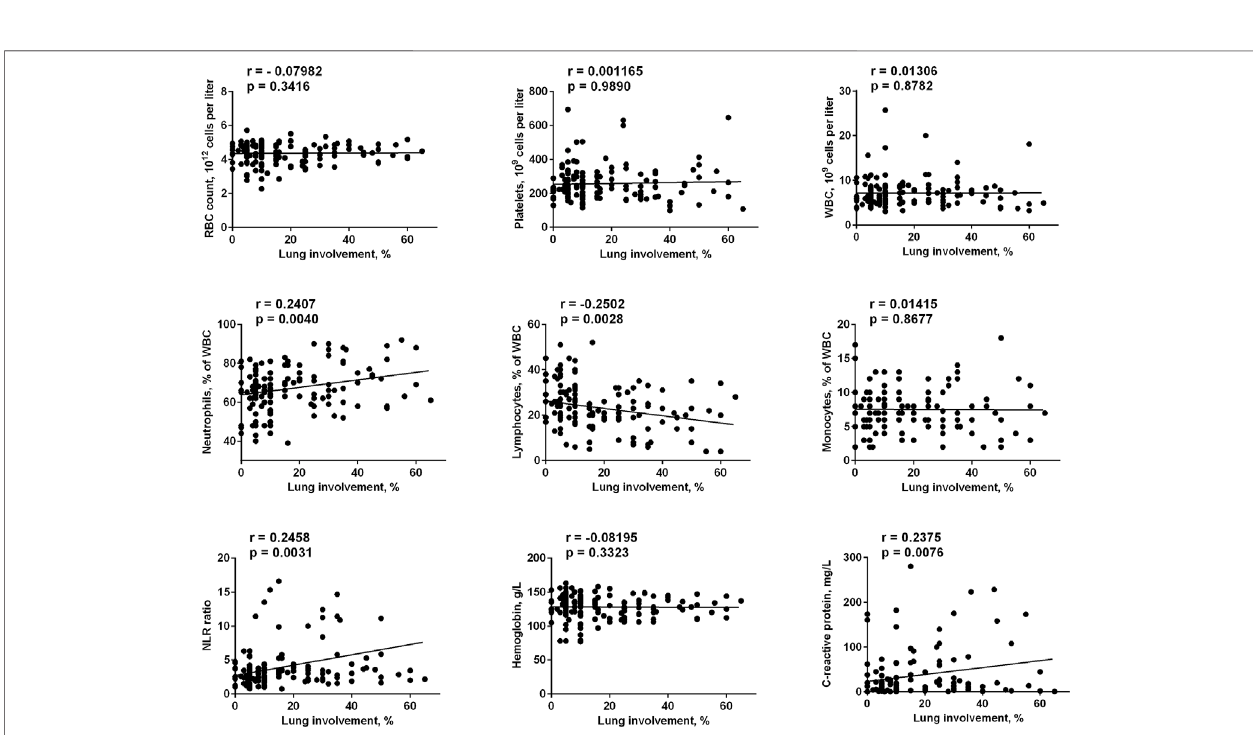
FIGURE 1 | Correlation of main blood and biochemical parameters taken on admission to the hospital with the lung involvement in chest computed tomography. The data on day 1 for FMN group and days 1 and 7 for control group were used.